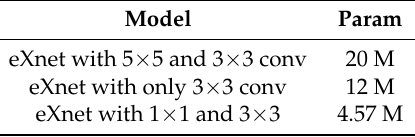
Table 3. Comparison between sizes of eXnet with different sizes of kernels in convolutional layers.